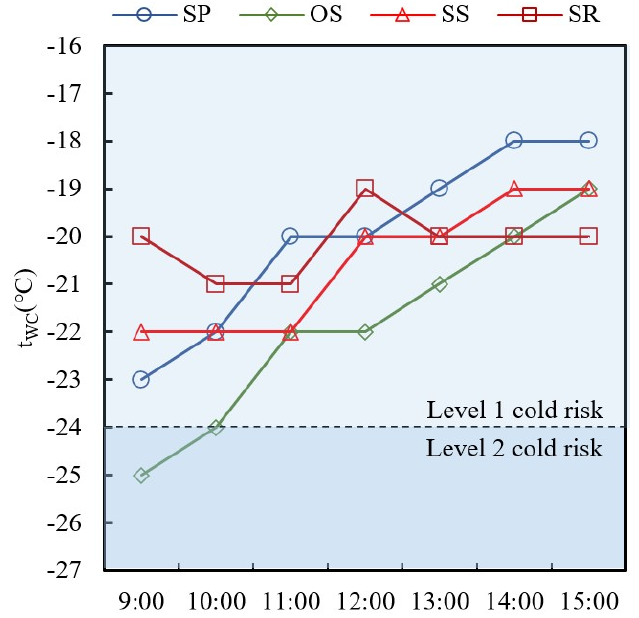
Figure 13. Daytime variation of wind chill temperature in the four open spaces. Table 8. Summary of the average T s of various materials in each space in winter.